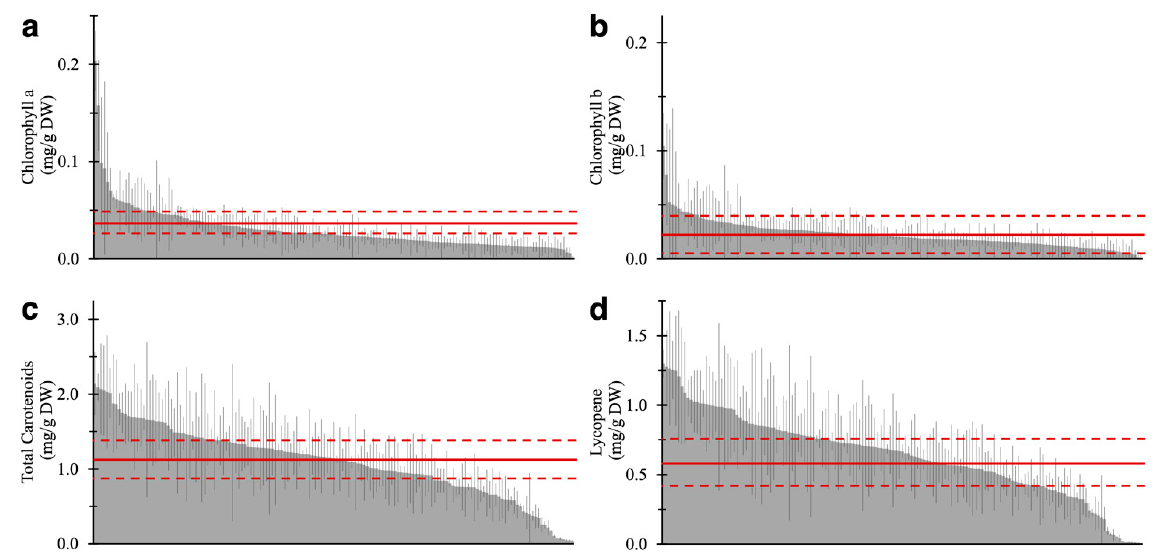
Figure 3. The four-pigment content in ripe fruit of 157 tomato varieties. ( a ) Chlorophyll a, ( b ) chlorophyll b, ( c ) total carotenoids, and ( d ) lycopene content are shown. The average and SD of the pigment content in AC are represented by the solid and dotted line, respectively. Each value is shown as the average of biological replicates ( n = 2–3) and analytical replicates ( N = 1–2) with SD.